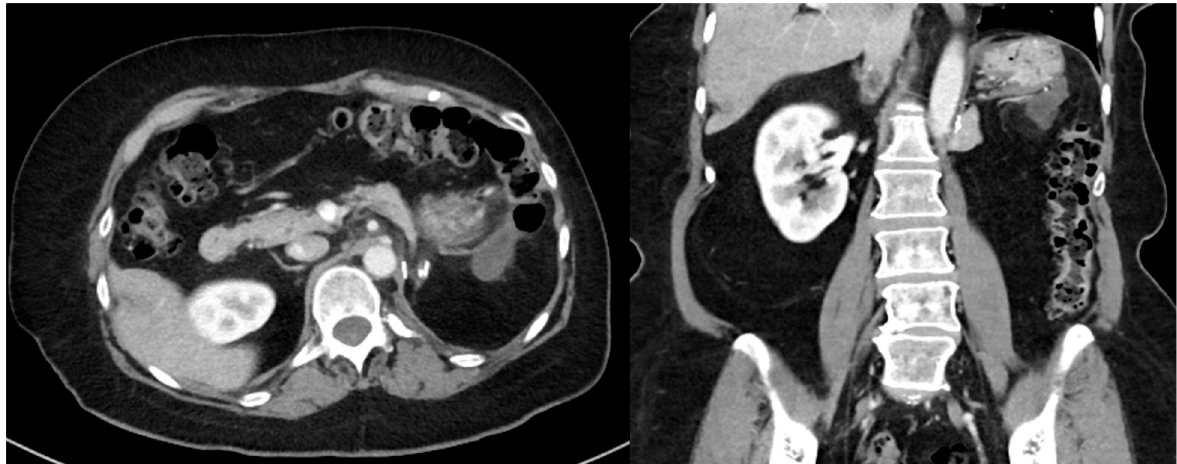
Figure 2. Recurrent well-differentiated liposarcoma requiring en bloc gastric wedge resection and partial colectomy. The index operation required en bloc left nephroureterectomy, left adrenalectomy, distal pancreatectomy, and